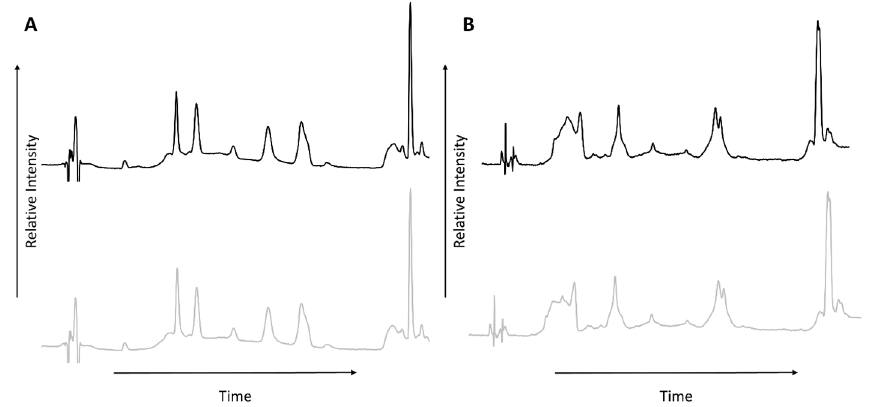
Figure 1. Representative High-Performance Liquid Chromatography-UV (HPLC-UV) chromatograms of matched unheated ( black ) and heated ( grey ) samples with heating to 60 °C ( A ) or 185 °C ( B ) at 254 nm.